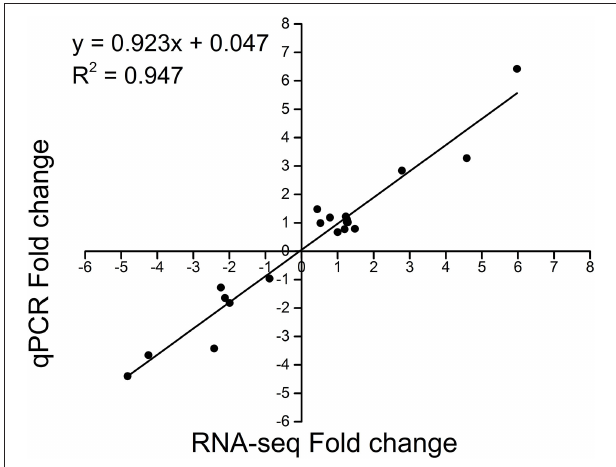
FIGURE 2 | Correlation of RNA-seq (y axis) and qRT-PCR data (x axis), and the assay is carried out for 20 randomly selected DEGs. GO and KEGG enrichment